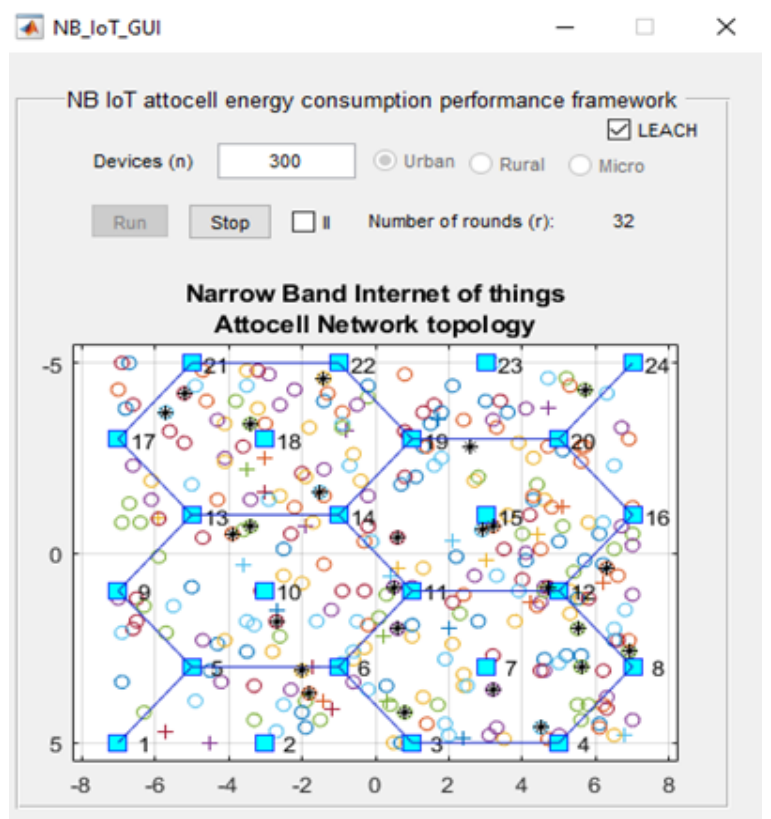
Figure 1. Graphical User Interface (GUI) of the NB-IoT open-sourced simulator.